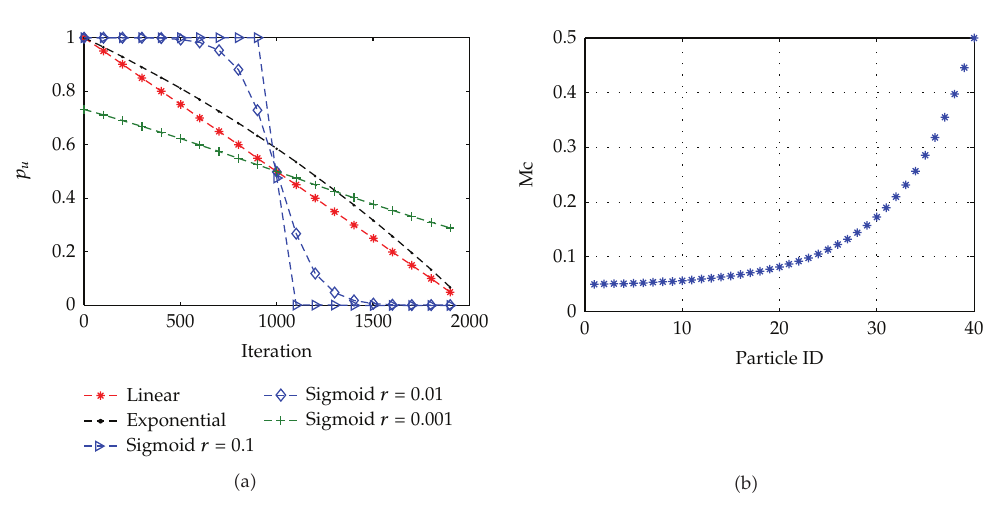
Figure 4: Mutation capability (cid:2) Mc (cid:3) and mutation